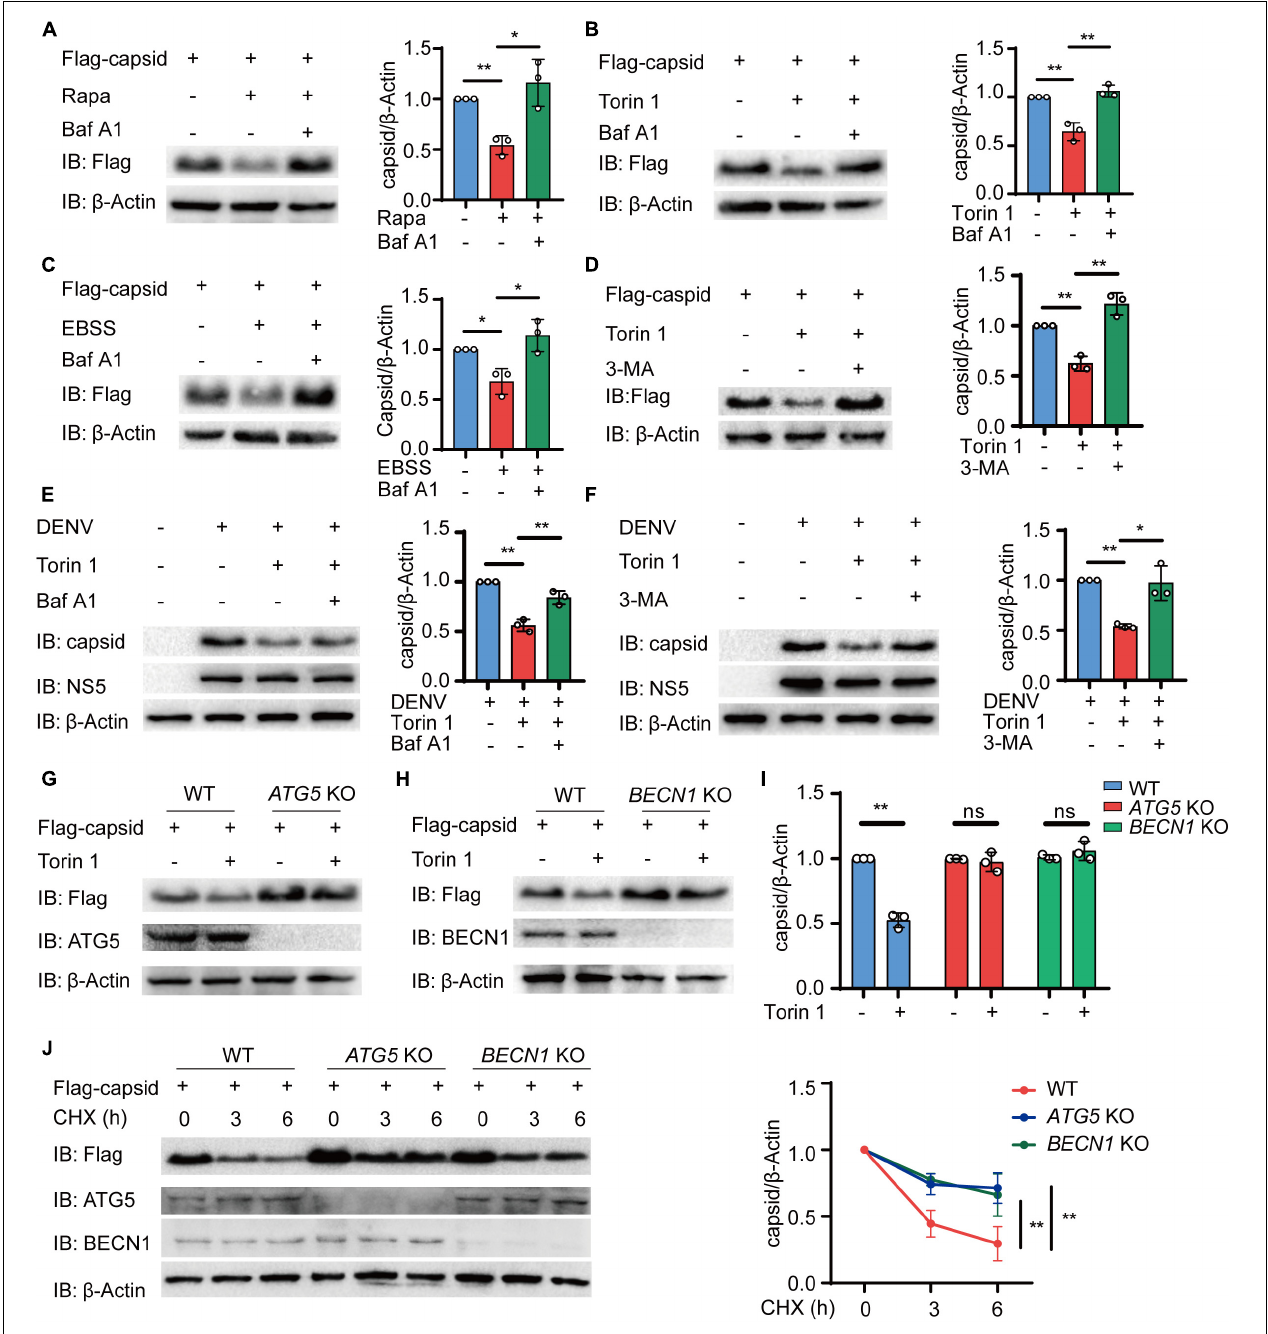
FIGURE 2 | Dengue virus (DENV) capsid protein is degraded in an autophagy-dependent manner. (A–C) 293T cells that stably expressed C protein were pre-treated with 0.2 µ M Baf A1 for 6 h, followed by treatments with 4 µ M Rapa (A) and 2 µ M Torin 1 (B) for 6 h or earle’s balanced salt solution (EBSS) (C) for 1 h. The cell lysates were immunoblotted with indicated antibodies, and the quantified levels of C protein were normalized to β -actin. (D) 293T cells that stably expressed C protein were pre-treated with 10 mM 3-MA for 6 h, followed by 2 µ M Torin 1 treatments for 6 h before harvesting. The cell lysates were immunoblotted with indicated antibodies, and the quantified levels of C protein were normalized to β -actin. (E,F) DENV (MOI = 0.5)-infected Huh7 cells were treated with 0.2 µ M Baf A1 for 6 h (E) or 10 mM 3-MA (F) for 6 h, followed by 2 µ M Torin 1 treatments for 6 h before harvesting. The cell lysates were immunoblotted with indicated antibodies, and the quantified levels of C protein were normalized to β -actin. (G,H) Flag-C protein was transfected into WT, ATG5 KO (G) , or BECN1 KO (H) cells, followed by 2 µ M Torin 1 treatment for 6 h. The cell lysates were immunoblotted with indicated antibodies. (I) Quantified levels of C protein from (G,H) were normalized to β -actin. (J) Flag-C protein was transfected into WT, ATG5 KO, or BECN1 KO cells, followed by treatments with cycloheximide (CHX) (100 ng/ml) for indicated time points. The cell lysates were subjected to immunoblot analysis with the indicated antibodies, and the quantified levels of C protein were normalized to β -actin. Data in (A–F, I,J) are expressed as mean ± SEM of three independent experiments. * p < 0.05, ** p < 0.01, ns, not significant (two-tailed Student’s t -test). All the experiments are representatives of three independent biological experiments with similar results.